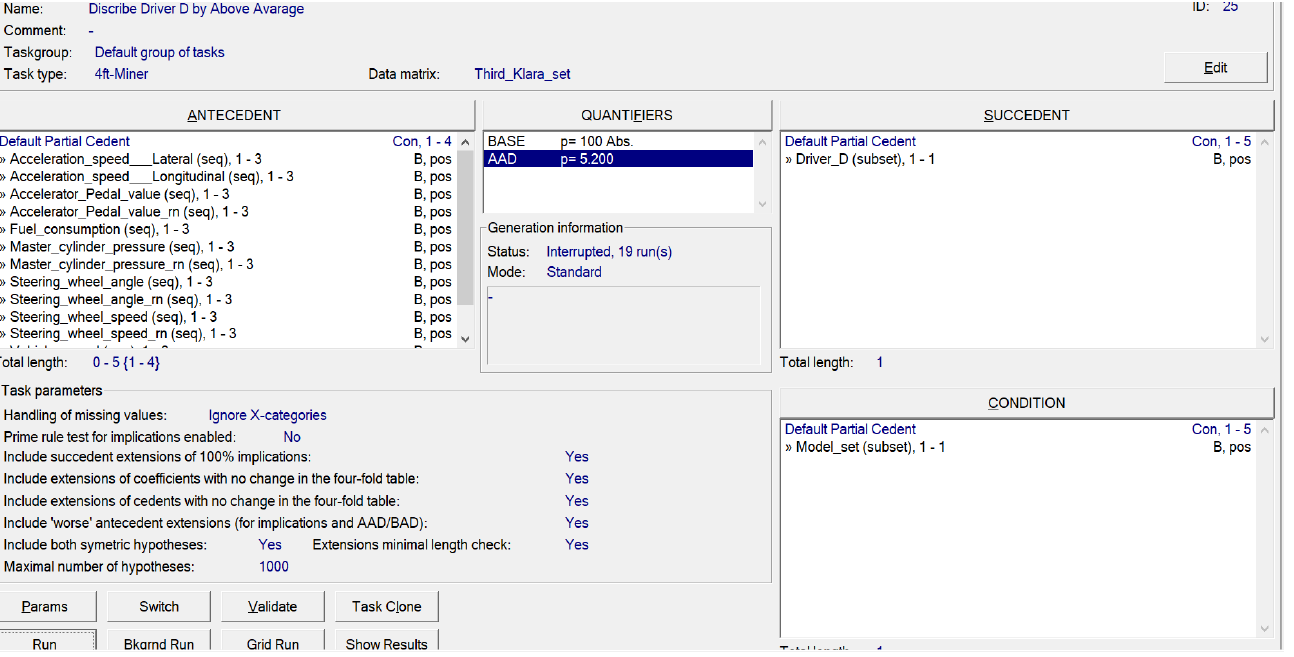
Figure 1. LISp-Miner screenshot when retrieving attributes describing driver D.